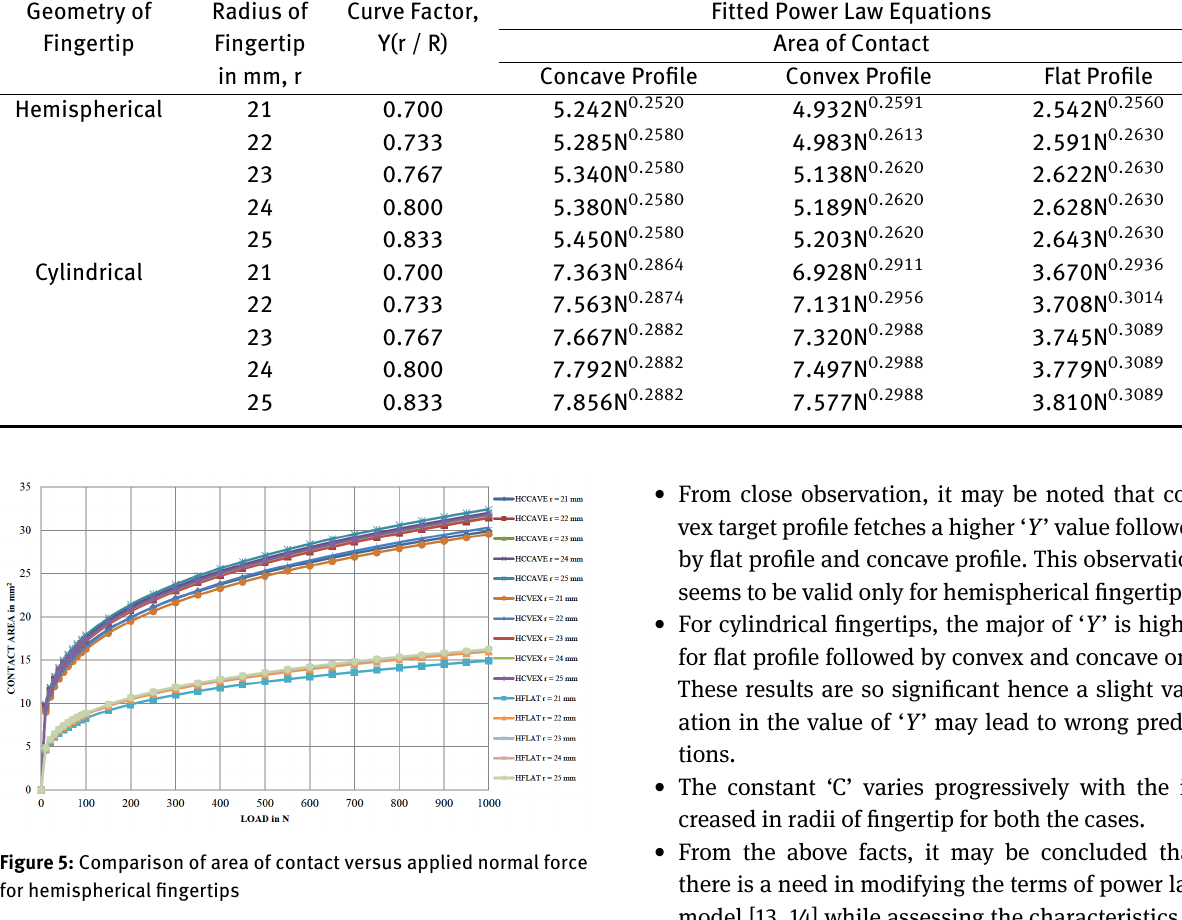
is derived from the current research work. The con- stant ‘ Υ ’ doesn’t vary with the size of fingertip. How- ever, it deviates upon the change in the profile of tar- get